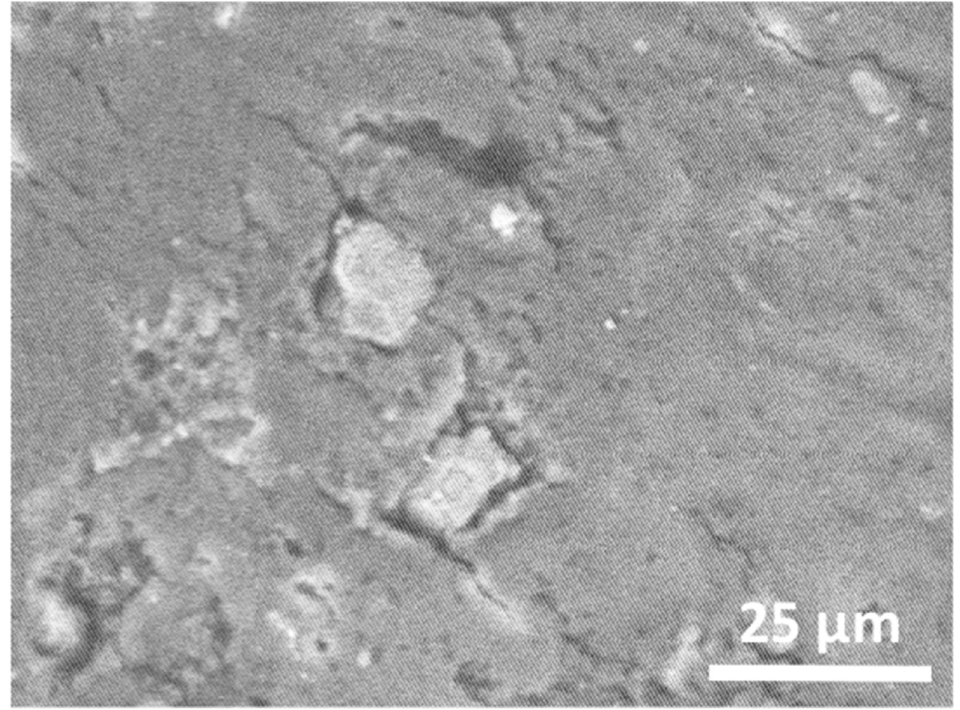
Figure 5. SEM micrograph of the dorsal part of a human nail after having been coated with np3 for 120 h.